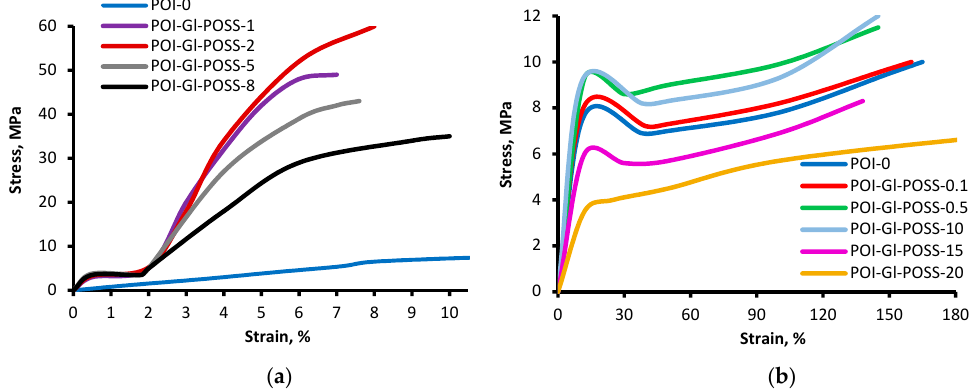
Figure 9. Mechanical tests curves of ( a ) POI-Gl-POSS for Gl-POSS content from 1 to 8 wt% and ( b ) for Gl-POSS content up to 0.5 wt% and more than 10 wt%.